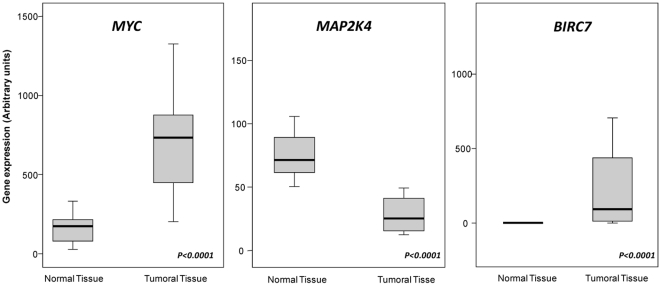
Expression levels of MYC, MAP4K and BIRC7 mRNA as assessed by RQ-PCR in metastatic CRC tumors and their corresponding paired normal tissue (n = 18).Note that MYC and BIRC7 mRNA levels from metastatic CRC tumours samples are significantly higher than in their paired normal tissues (p<0.0001). By contrast, MAP4K mRNA levels in metastatic CRC tumors are significantly lower than normal (p<0.0001).